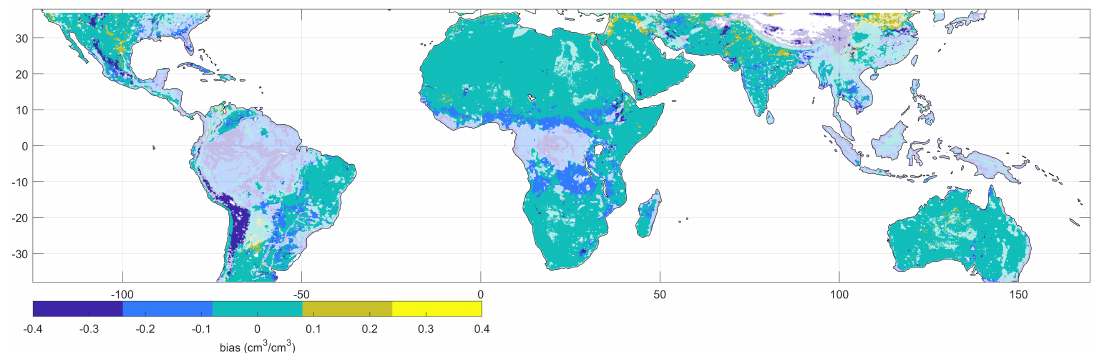
Figure 5. Bias between CYGNSS-based model prediction and SMAP retrievals. Semi-transparent regions are those flagged by SMAP as having an uncertain SM retrieval